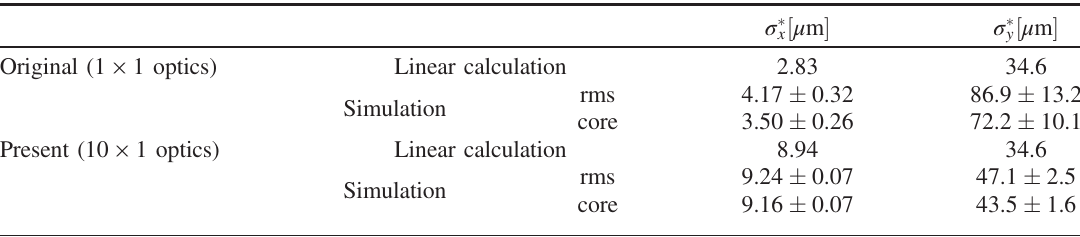
TABLE III. Simulated beam size with only linear knobs for the original ATF2 optics and the present ATF2 optics. “ rms beam size ” is the standard deviation of the y distribution of the tracked particles at the IP. “ Core beam size ” is the width of a Gaussian function fitted to the core of this distribution. The (cid:3) shows the standard deviation of the simulated beam size at the IP.